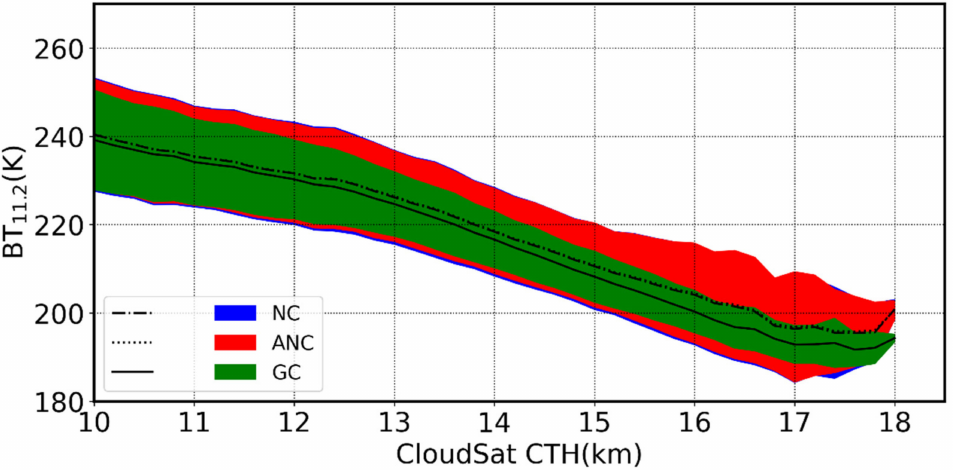
Figure 3. Standard deviation and the average value of BT 11.2 as the function of CloudSat CTH. Three kinds of lines indicate the average value while shadows of different colors (blue, red, and green) show the STD of BT 11.2 from NC, ANC, and GC